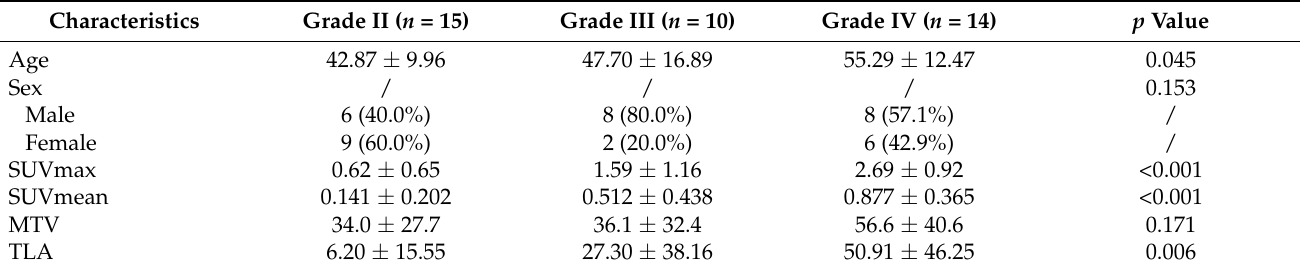
Table 1. Baseline characteristics of the enrolled